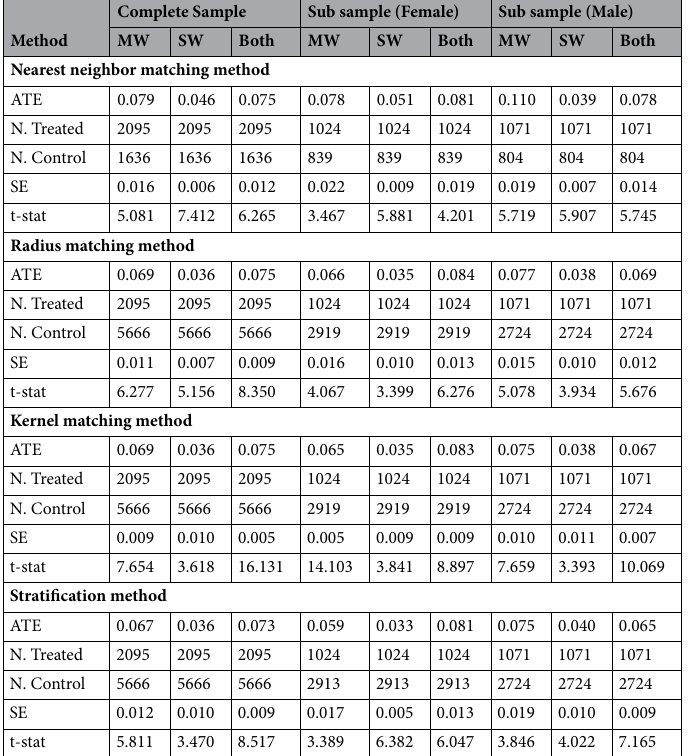
Table 3. Average treatment effect of LBW under various methods of PSM on malnutrition. MW (Moderate wasting); SW (Severe wasting); both (moderate wasting and moderate